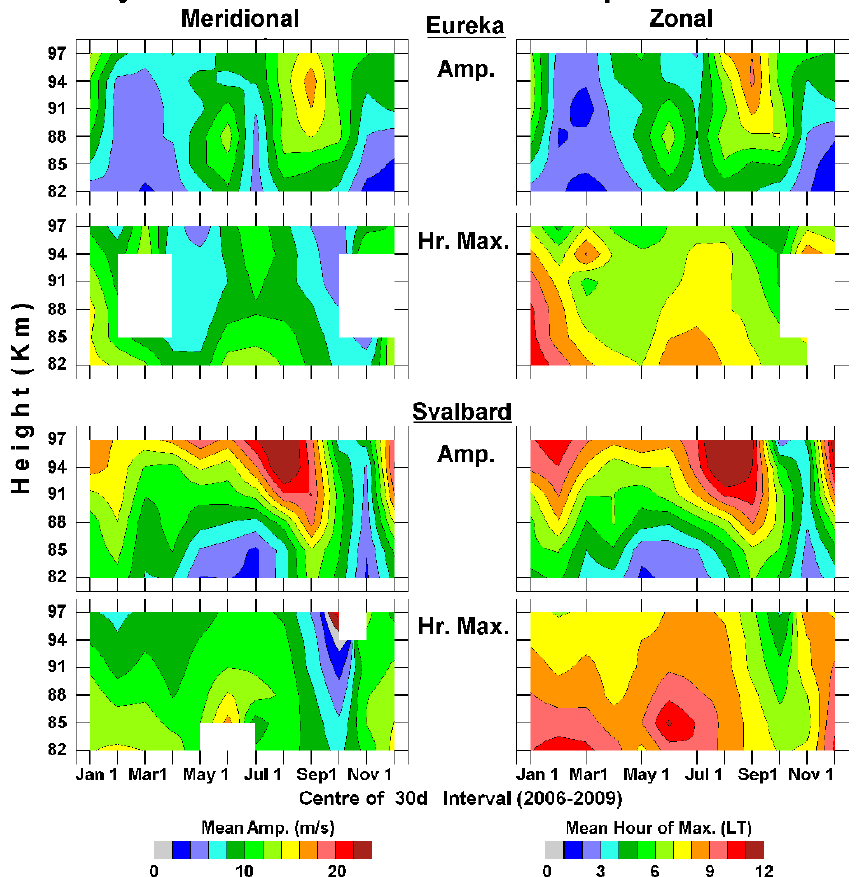
Fig. 5. Zonal ( U , EW) and meridional ( V , NS) winds for the semi-diurnal (12-h) tides (SDT) above Eureka and Svalbard for days Febru- ary 2006–February 2009: the phases are the local solar times of maximum northward and eastward winds. Separate averaging for amplitudes and phases was done for the tides, and if the phase-spread between the values from three years exceeds 180 ◦ for an interval, a phase-gap is shown. 30-day fits are used, with the first day of the calendar month as the middle of the 30-day data